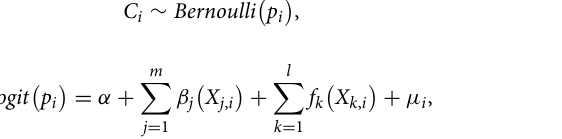
for binomial family, p i is the expected value of the response variable (the probability of B. anthracis suitability) at location i , α is the intercept, X j , i and X k , i are the j th and the k th covariates at a location i , β j are the beta coef- ficients, f k are the smooth functions (cubic regression splines) for k th covariates, and µ i is the spatial random effect at the location i 53 . The number of variables in linear term ( m ) and the non-liner term ( l ) are different because the variables employed in each term are different. We estimated both linear and non-linear effects for the covariates. Our overall database had 294 B. anthracis pseudo-absences generated randomly across the target background buffers to match the number of species presences recorded. Because we had no prior information, a Gaussian prior distribution with a mean of zero (default no effect prior unless data is informative) was applied for all the model parameters. The posterior mean, standard deviation, and 95% credible intervals were estimated for all the parameters. Model selection.